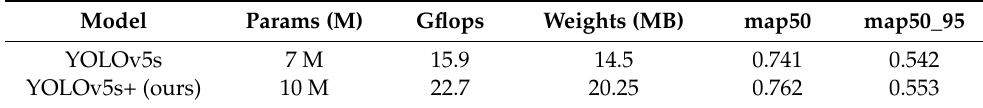
Table 2. Test of improved YOLOv5s on VOC2019 car dataset.